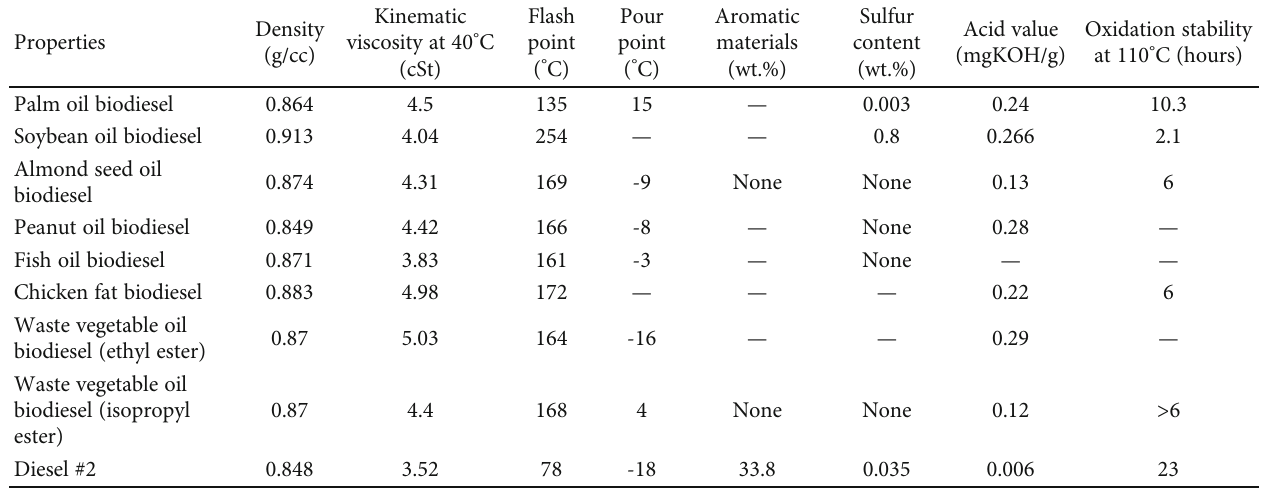
Table 1: Basic properties of di ff erent types of biodiesel compared with diesel.